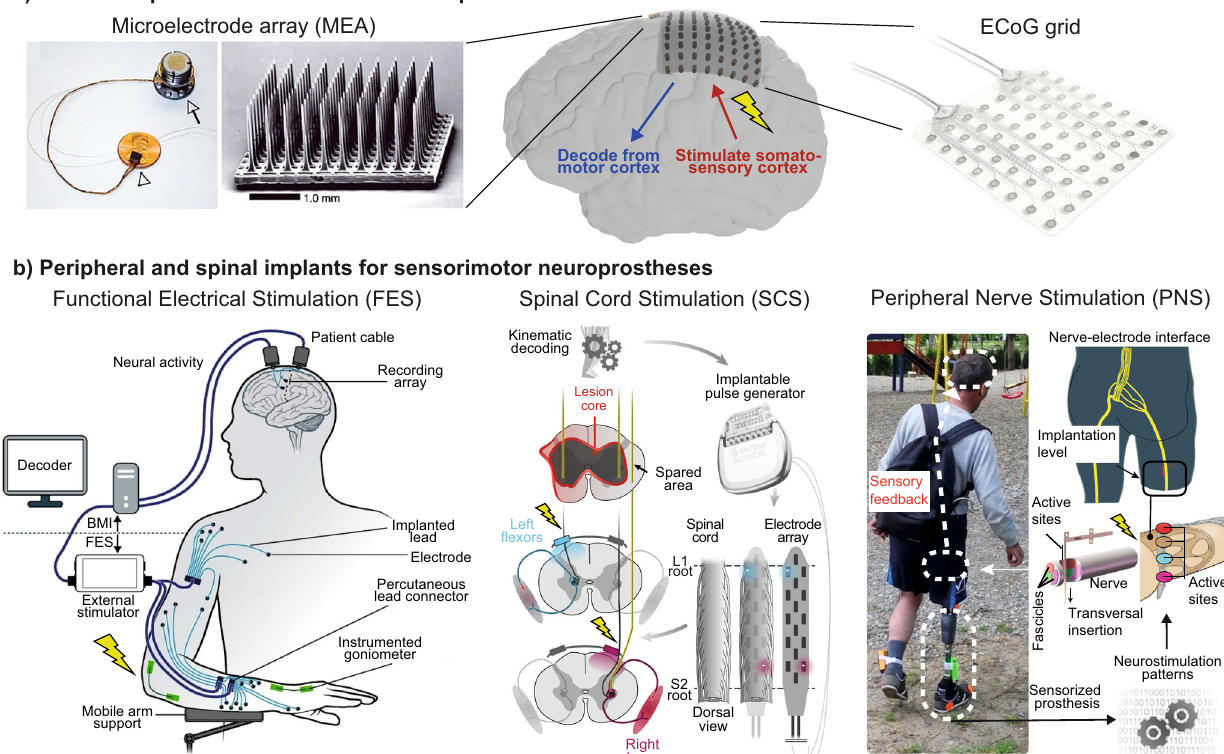
Fig. 1 Neuroprosthetic technologies for sensorimotor disorders. a Cortical implants typically used for sensorimotor neuroprostheses can be divided into two categories: intracortical MEAs such as the Utah array (10 × 10 Utah array, picture extracted with permission from ref. 55 ), and epidural or subdural ECoG strips or grids with different speci fi cations (illustrated for a 8 × 8 ECoG grid, 4 mm contact diameter, 10 mm pitch, with permission from CorTec GmbH). These implants can both record neurophysiological signals and deliver electrical stimulation. b Peripheral and spinal implants for sensorimotor neuroprostheses target either the motor nerves or muscles in the case of FES (adapted with permission from ref. 66 ), the spinal cord in epidural SCS (adapted with permission from ref. 13 ), or the sensory nerves in PNS for somatosensory feedback (adapted with permission from ref. 80 ). All applications shown here used these implants for delivering electrical stimulation. Lightning bolts indicate